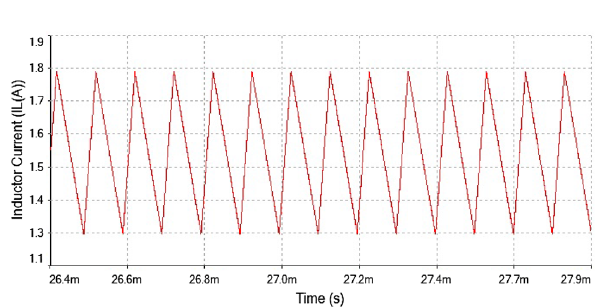
Figure 20. Inductor current waveform for forward converter at R L = 4 (cid:31) .